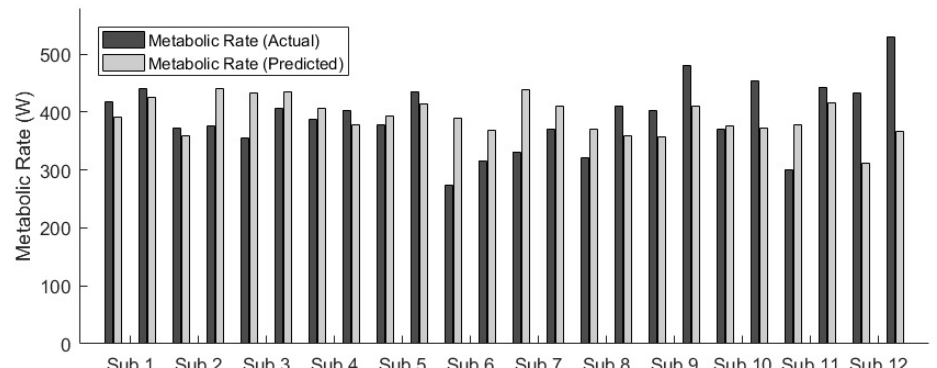
Figure 4. Metabolic rate modeling results across individuals. The trend of the predicted metabolic rates in general followed that of the actual metabolic rates across individual subjects. Average absolute and percent errors for the metabolic rate model were 54.9 W and 14.4%, respectively. Similarly, the trend of the predicted energy harvesting rates in general followed that of the actual energy harvesting rates across individual subjects (Figure 5).